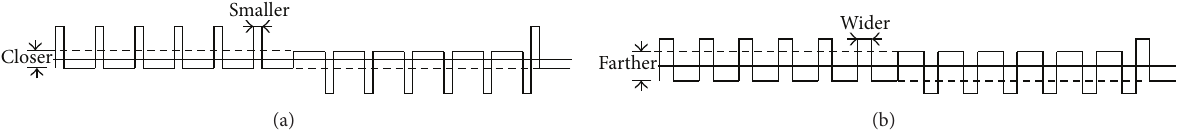
Figure 2: Two different cases of complementary duty cycles are shown. The left trace (a) has more distinct duty cycles. The right trace (b) has duty cycles closer to 50%. Both traces are weighted above and below the zero mean value (horizontal) line.